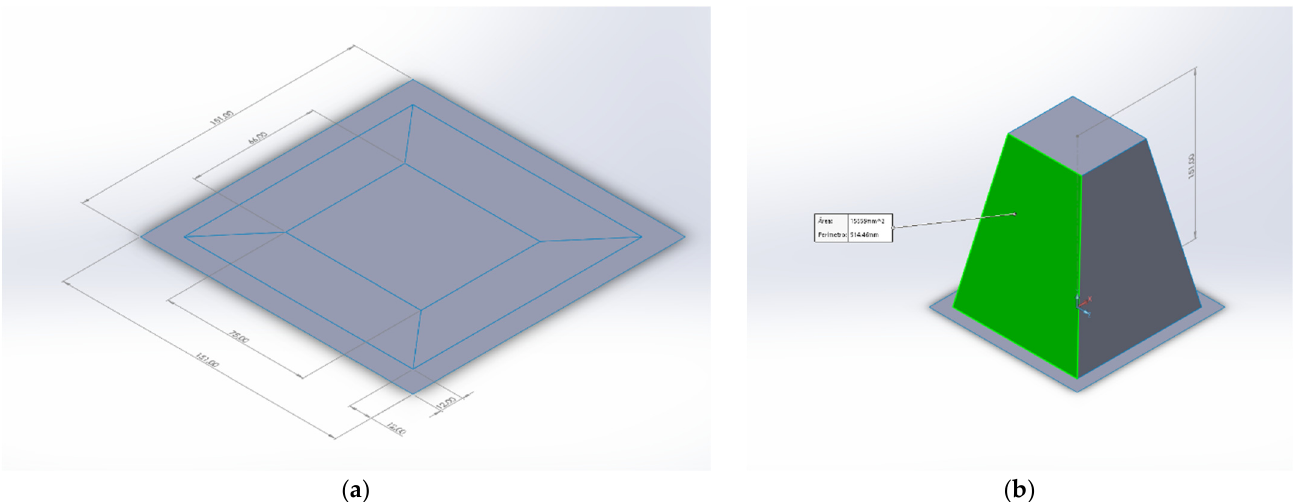
Figure 10. Model used to compute an approximation to the area of the thermoformed film: ( a ) Original film and area definition ( b ) Thermoformed model.